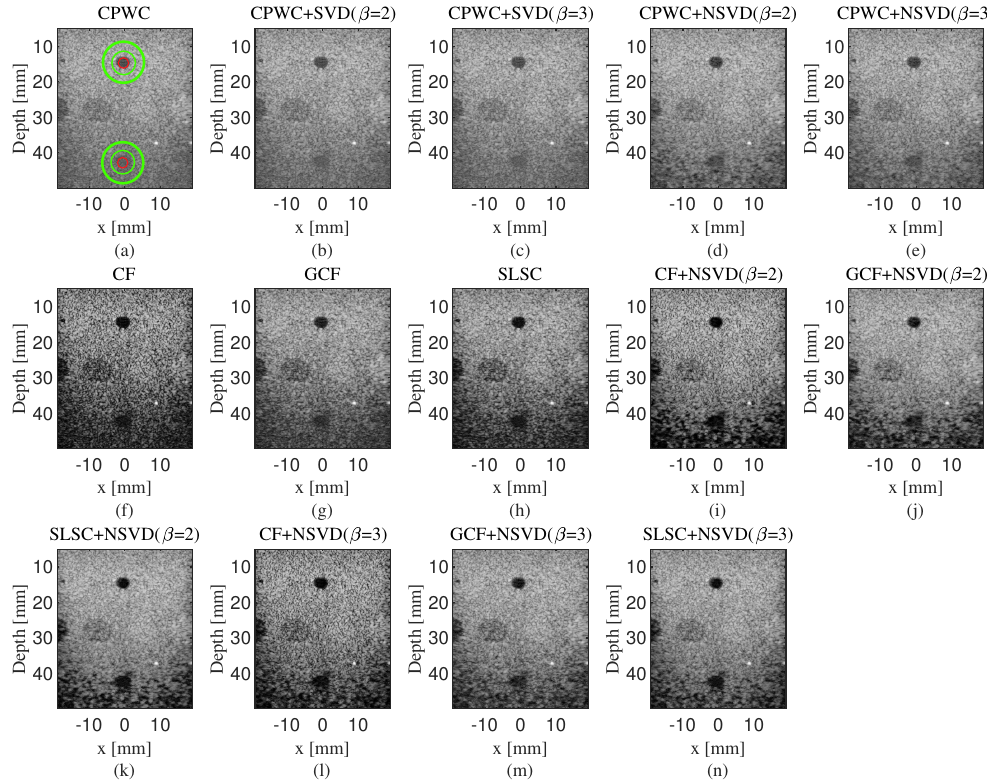
Figure 11. B-mode images of experimental phantom with cyst targets formed by different methods. ( a ) CPWC, ( b ) CPWC+SVD ( β = 2), ( c ) CPWC+SVD ( β = 3), ( d ) CPWC+NSVD ( β = 2), ( e ) CPWC+NSVD ( β = 3), ( f ) CF, ( g ) GCF, ( h ) SLSC, ( i ) CF+NSVD ( β = 2), ( j ) GCF+NSVD ( β = 2), ( k ) SLSC+NSVD ( β = 2), ( I ) CF+NSVD ( β = 3), ( m ) GCF+NSVD ( β = 3), ( n ) SLSC+NSVD ( β = 3). The area in the red circle and between the two green circles indicates inside and outside the cyst, respectively, used for calculating CR, CNR, gCNR, and sSNR.